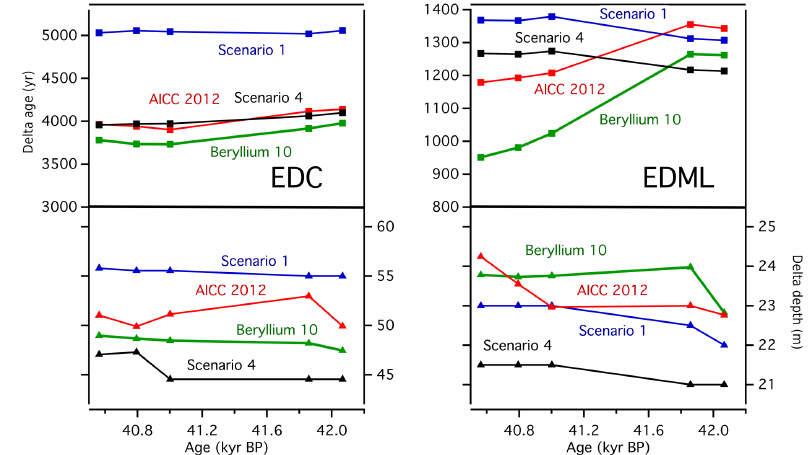
Figure 5. (cid:49) age and (cid:49) depth derived for the five 10 Be tie points derived in this work compared with their values as used in scenario 1 and 4 (Loulergue et al., 2007) and for AICC2012 (Bazin et al., 2013).